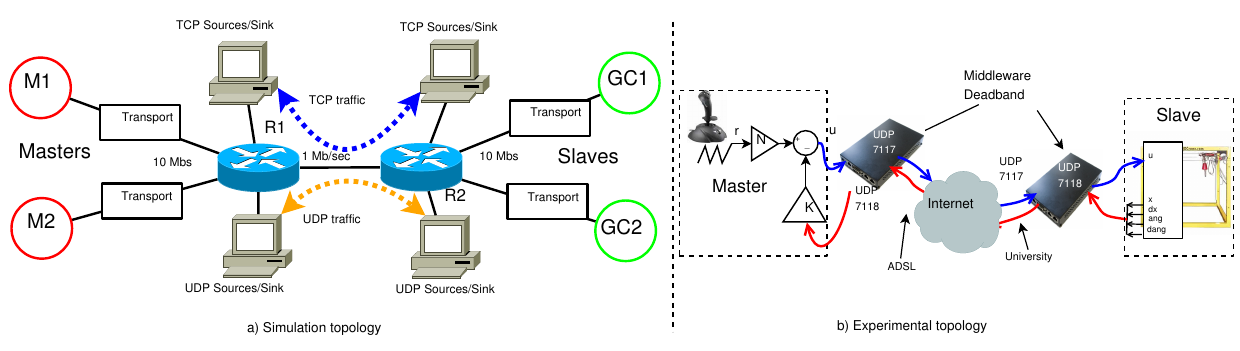
Figure 10. Simulation ( a ) and Experimental ( b )